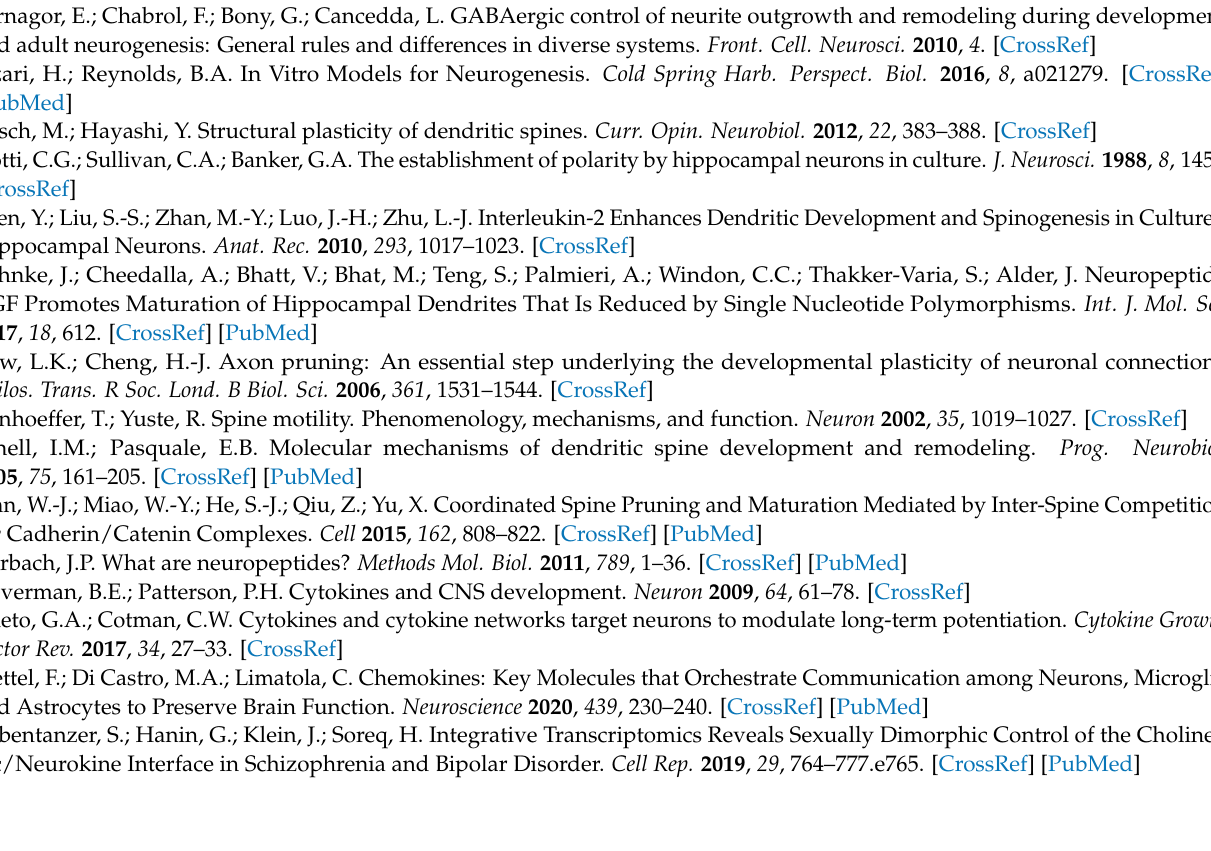
(postnatal day 63), Figure S5: Dendritic spine morphology of motor cortical layer 4 (L4) spiny stellate neurons in postnatal Fam19a1 − / − mice, and Figure S6: Spine morphology of